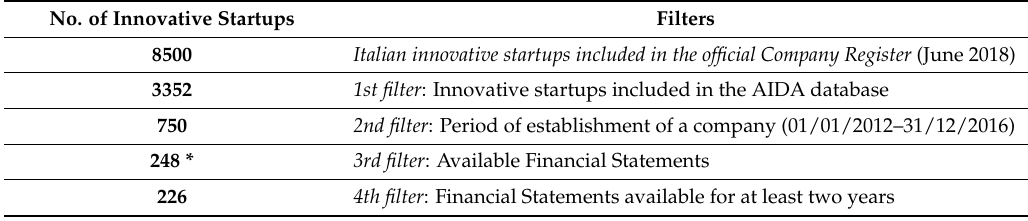
Table 1. The sample selection